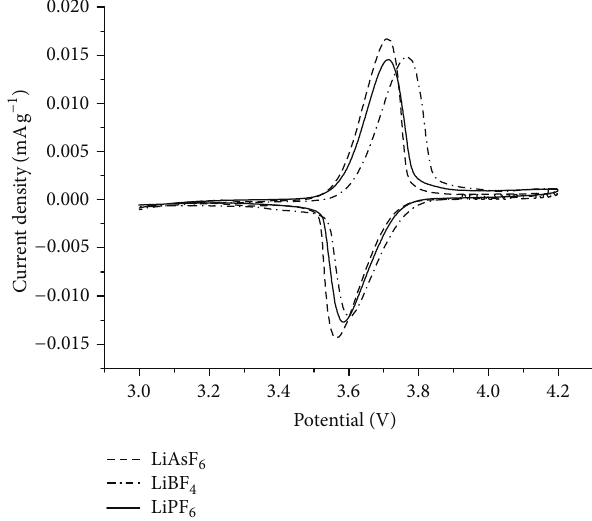
Figure 6: The cyclic voltammogram of the organic cathode active polymer with different